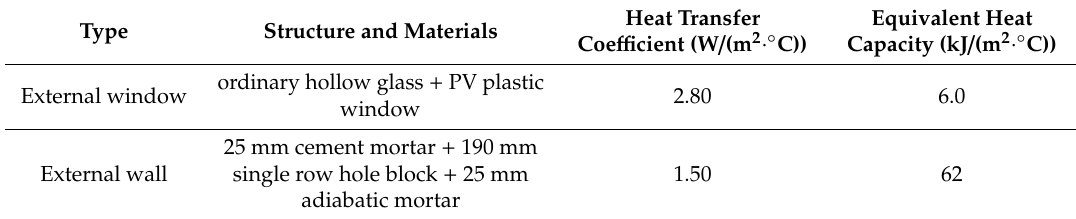
Table 5. Structure and material properties of the envelope structure [25].